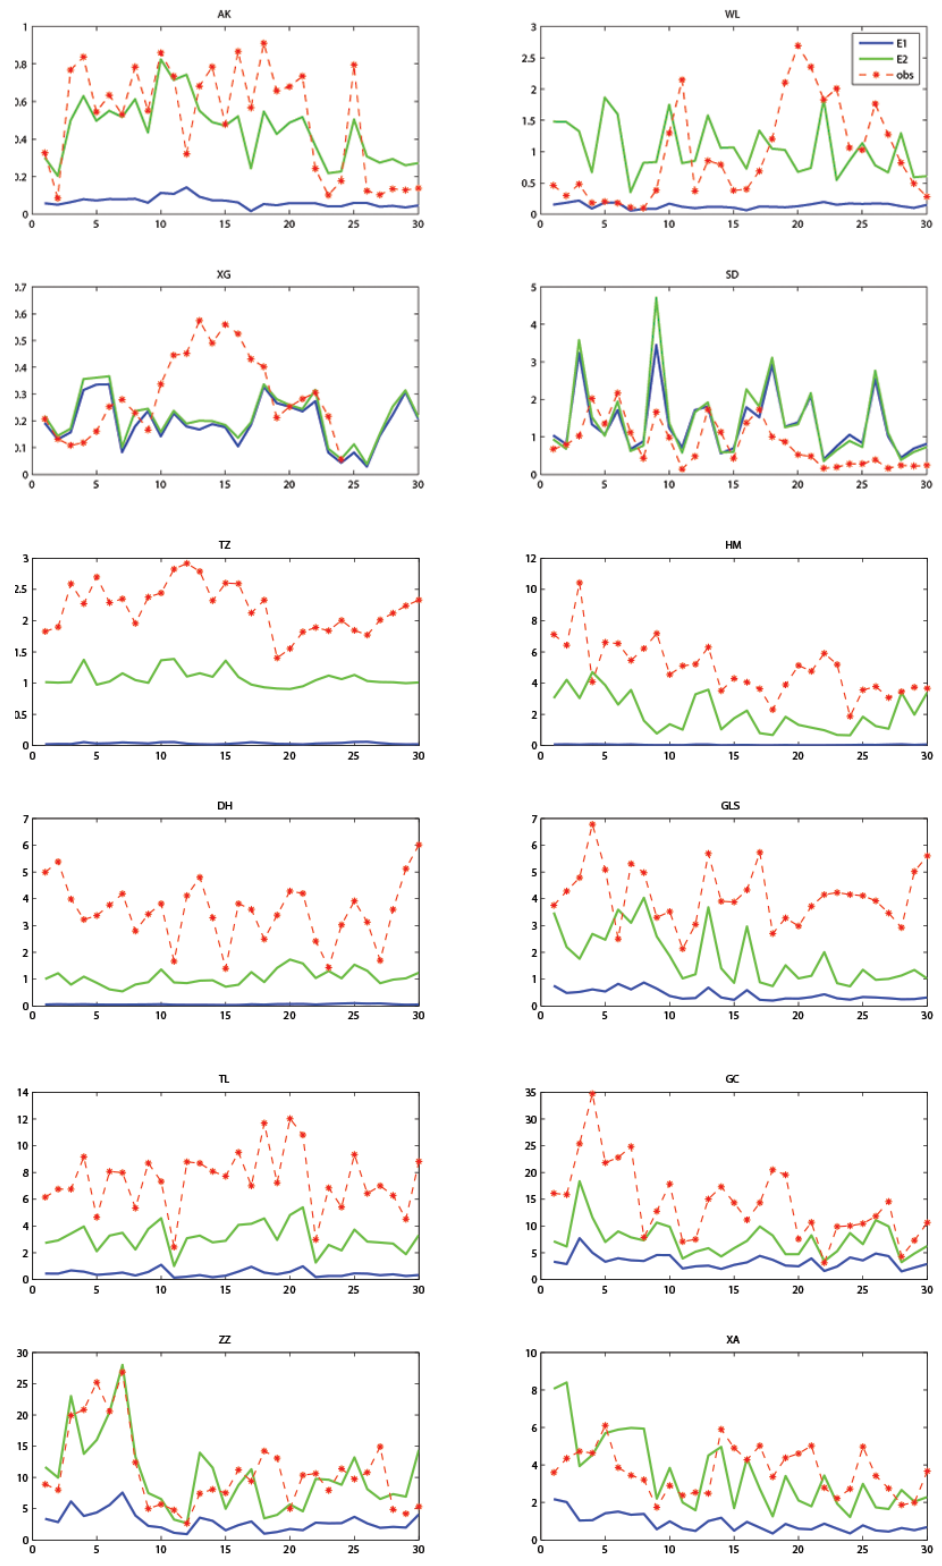
Figure 7. BC daily concentrations in January 2008 (units: µgm − 3 ). The red dotted line shows the observation; the blue line is the model simulation driving by prior emissions (E1); and the green line is the model simulation driven by inverse emissions (E2).